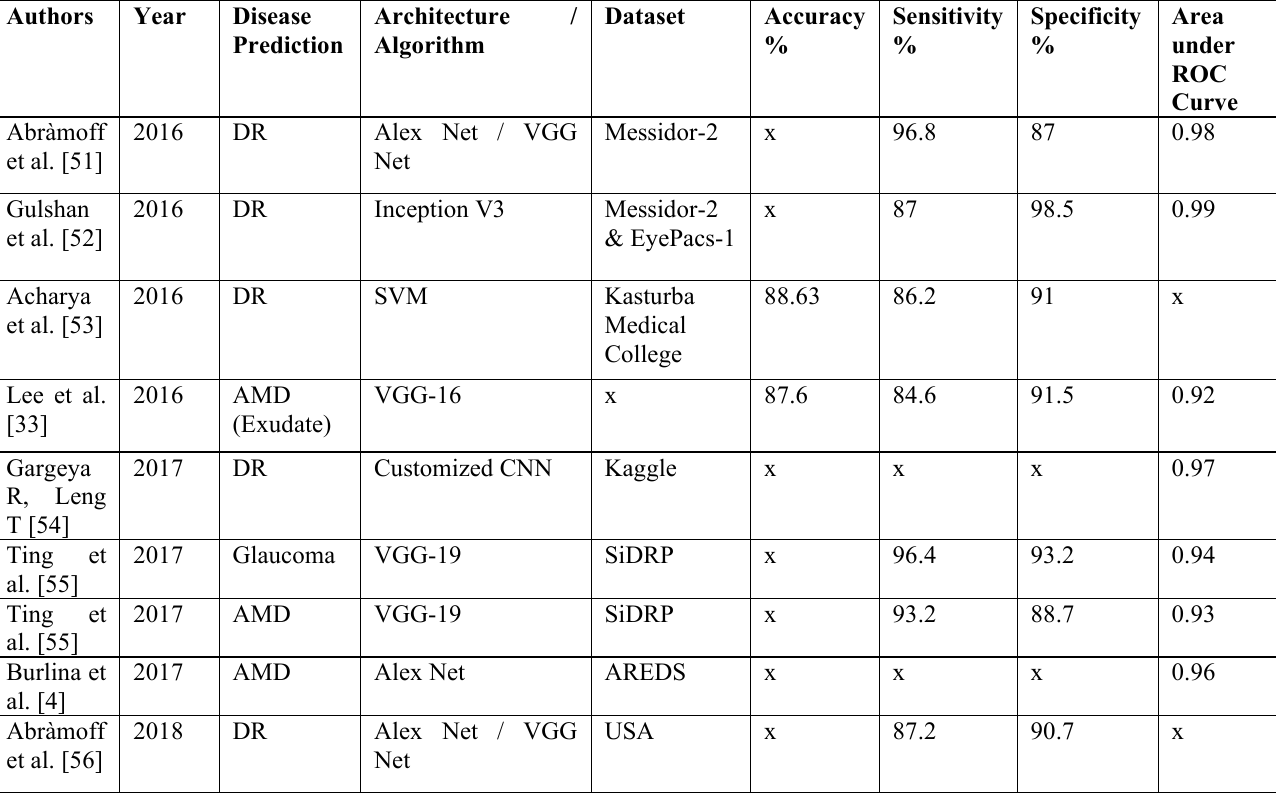
Table 4. Comparative analysis of DR, AMD and Glaucoma detection through Deep Learning